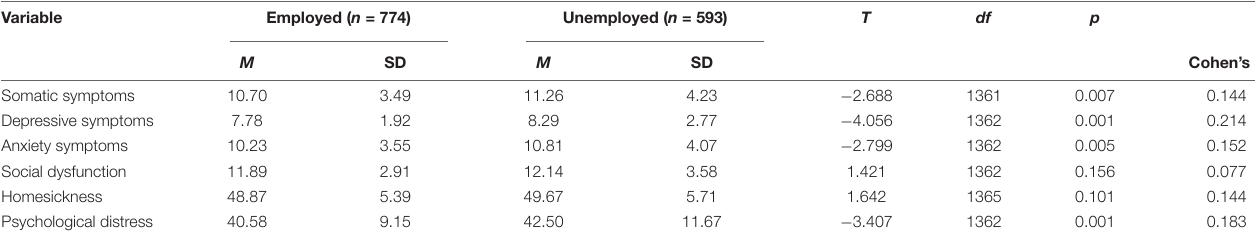
TABLE 3 | Differences in psychological distress, somatic symptoms, depressive symptoms, anxiety symptoms, social dysfunction, and homesickness in relation to employment/unemployment.